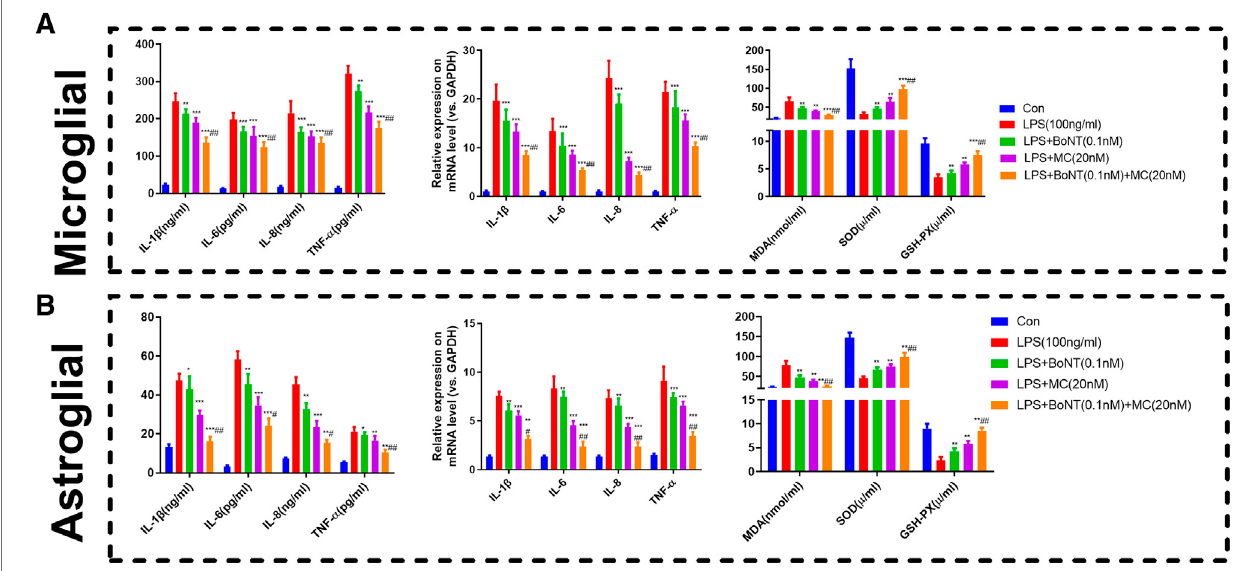
FIGURE 5 | Combination of BoNT and MC distinctly attenuated in fl ammatory response and oxidative stress in glial cells. (A-B) RT-qPCR and ELISA were used to detect alteration in in fl ammatory response and oxidative stress products (* p < 0.05, ** p < 0.01, *** p < 0.0001 V.S LPS; # p < 0.05, ## p < 0.01, ### p < 0.0001 V.S LPS + BoNT or and LPS + MC, N (cid:2) 5).